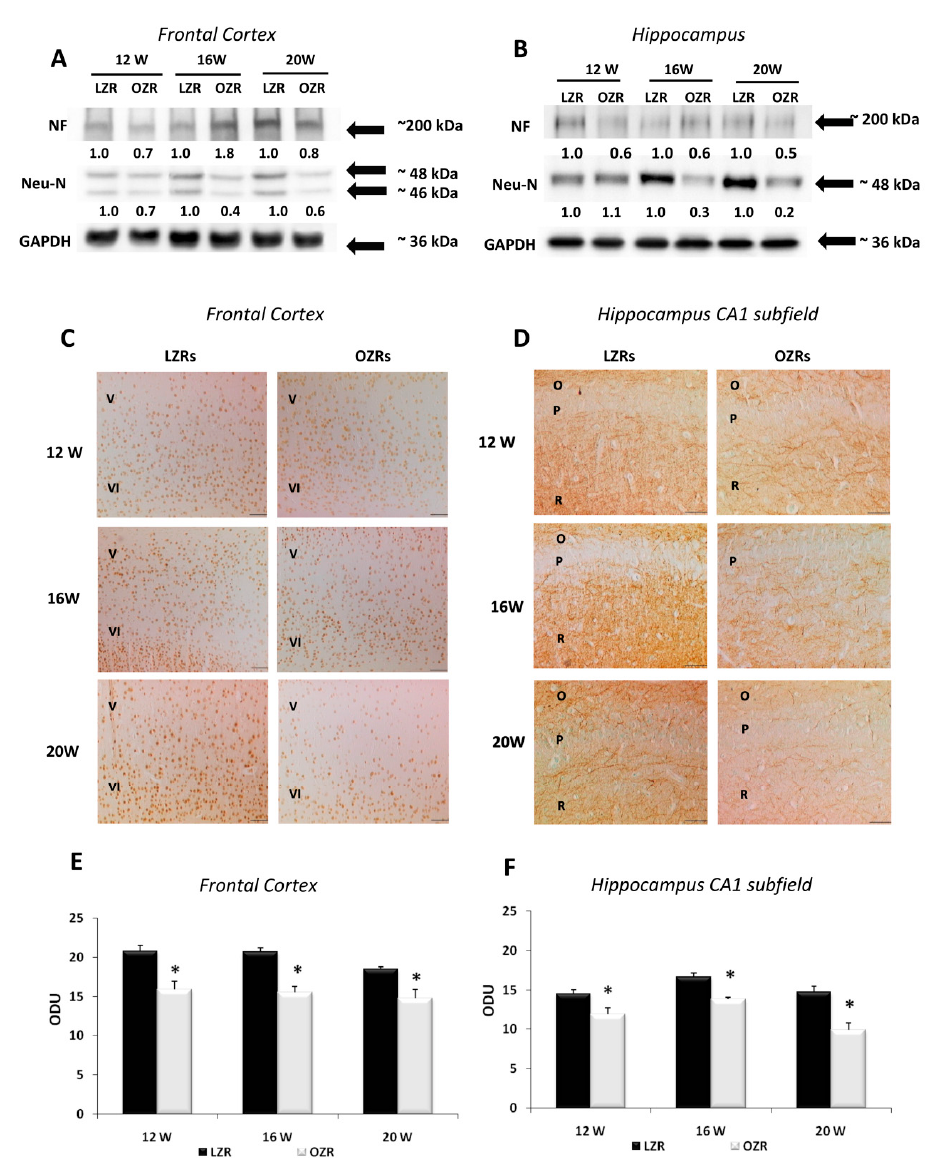
Figure 3. Neuronal markers. Immunochemical analysis of the frontal cortex ( A ) and hippocampus ( B ) processed with different antibodies anti-neurofilament (NF) and anti-neuronal nuclei protein (NeuN). To investigate more than NF and NeuN proteins on the same blot, both membranes of the frontal cortex and hippocampus were stripped and incubated with anti-GAPDH antibody (loading control). The densitometric analysis of bands is expressed as the ratio between the optical density of protein and reference protein (GADPH) where the value for LZRs of different ages is set as 1. Blots are representative of one of three separate experiments. ( C ) Sections of the frontal cortex of LZRs and OZRs of 12-, 16-, and 20-weeks age processed for the immunohistochemistry against Neu-N protein, to identified cell body neurons. V, VI: fifth and sixth layers of the frontal cortex. Magnification 20X. Calibration bar: 50 μ m. ( D ) Sections of the hippocampus (CA1 subfield) of LZRs and OZRs of different weeks of age processed for the immunohistochemistry against axonal NF. O: stratum oriens ; P: pyramidal neurons; R: stratum radiatum . Calibration bar: 50 μ m. Densitometric analysis of the frontal